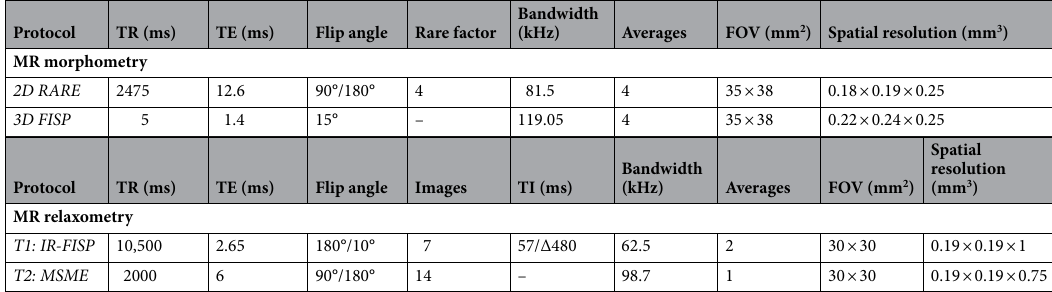
Table 2. Overview of the applied MR protocols. The MR morphometry comprised a high resolution 2D rapid acquisition with relaxation enhancement (RARE) and a 3D fast imaging with steady-state precession (FISP) sequence. The T1 relaxation time was measured based on a Look-Locker approach sampling the T1 dynamic using an inversion recovery FISP (IR-FISP) technique. The transversal relaxation time T2 was derived from a multi-slice multi-echo (MSME)